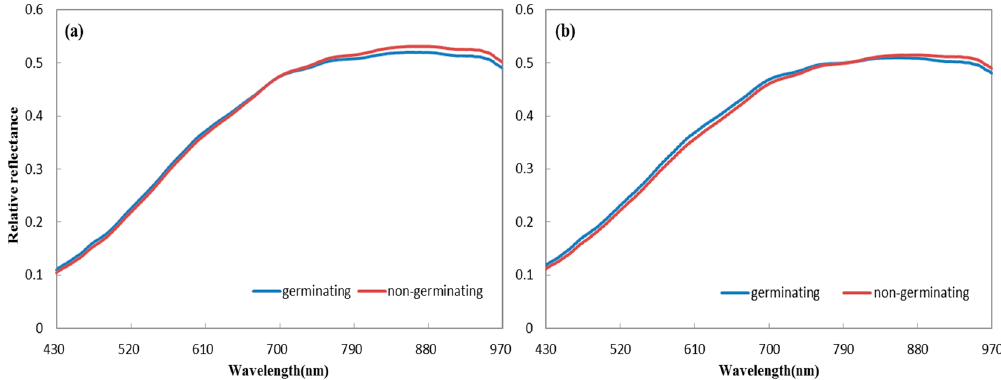
Figure 3. Average spectra of germination and non-germination seeds for ( a ) the ventral groove side and ( b ) the reverse side.